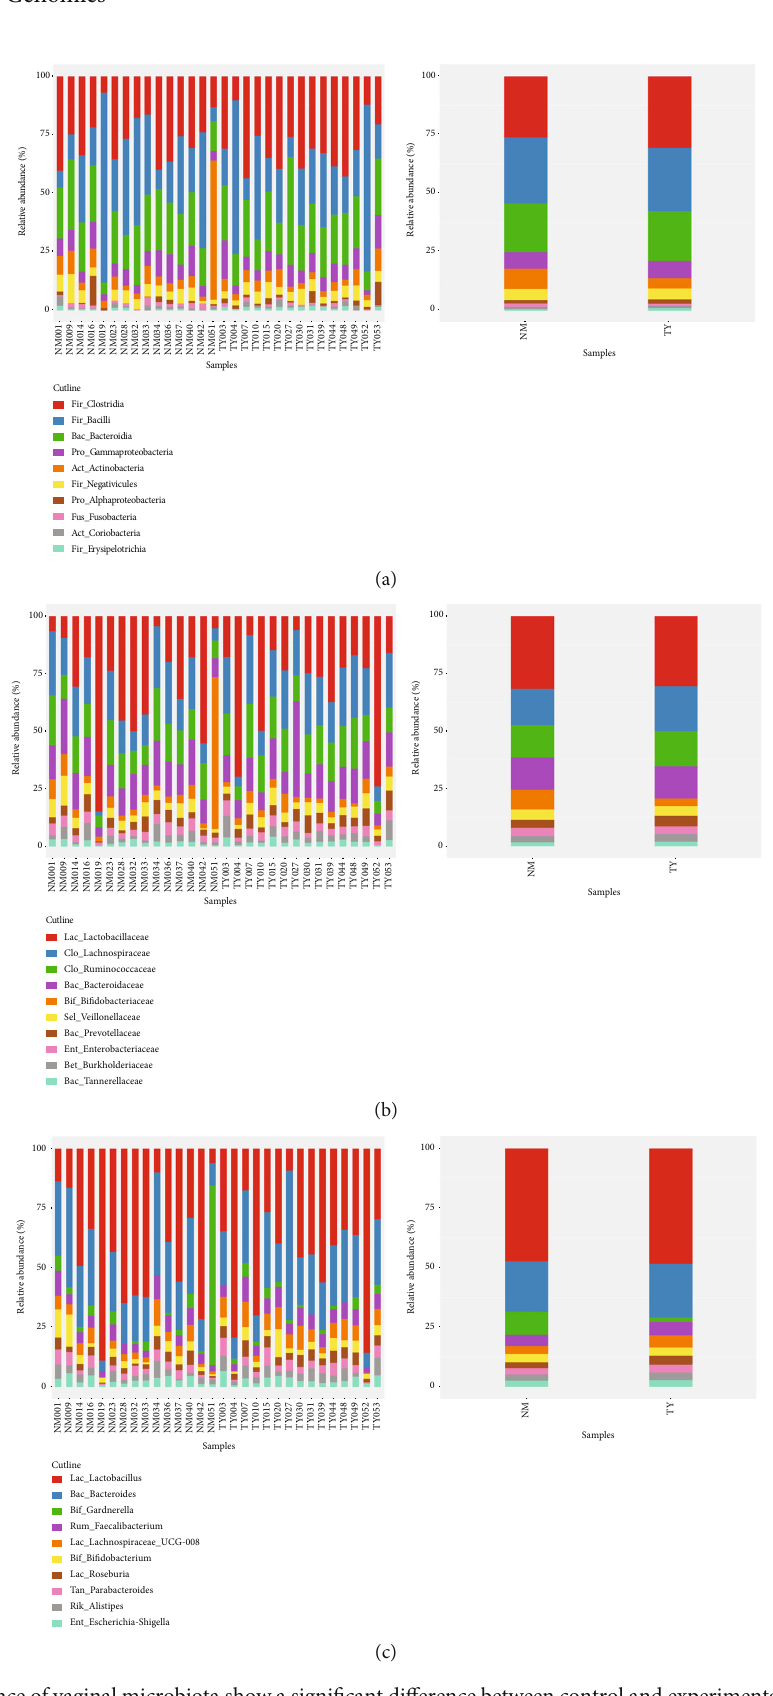
Figure 3: Relative abundance of vaginal microbiota show a signi fi cant di ff erence between control and experimental group. (a) Class level; (b) Family level; (c) Genus